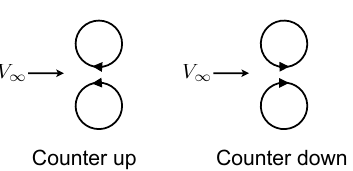
Figure 16. Two cases for a counter rotating pair of turbines. “Counter Up” refers to the pair with a rotation direction facing up- stream at their closest interface, whereas the “Counter Down” con- figuration rotates downstream at their closest interface. Table 2. Cleanfield 3.5kW VAWT